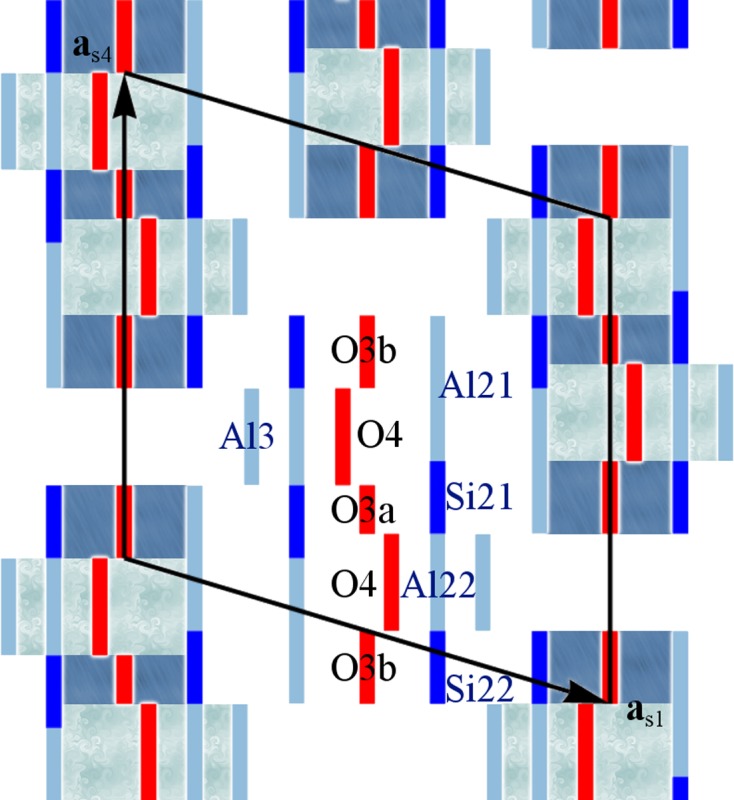
Section of the superspace model based on M40 #1 showing atomic domains relevant for Al/Si ordering. Displacive modulations are neglected here. Atomic domains that form part of the octahedra, i.e. Al1, O1 and O2, are not shown. Different background colours indicate dicluster and tricluster units. The domains of Al2, Si2 and O3 are described by more than one block wavefunction.